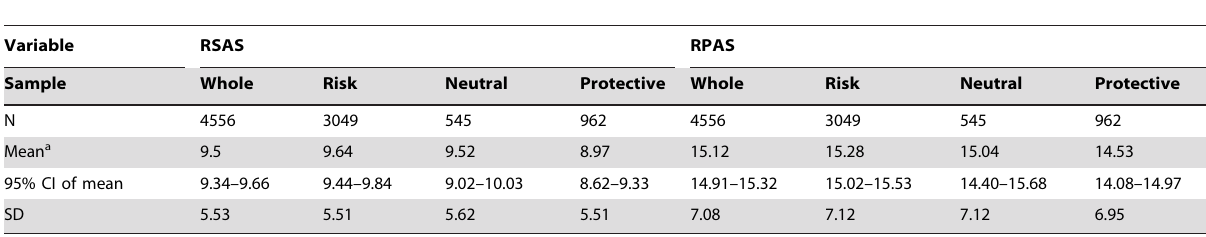
a Range for RSAS 0–40, range for RPAS 0–61. Abbreviations: RSAS: Revised Social Anhedonia Scale, RPAS: Revised Physical Anhedonia Scale, N: the number of individuals, CI: confidence interval, SD: standard deviation.